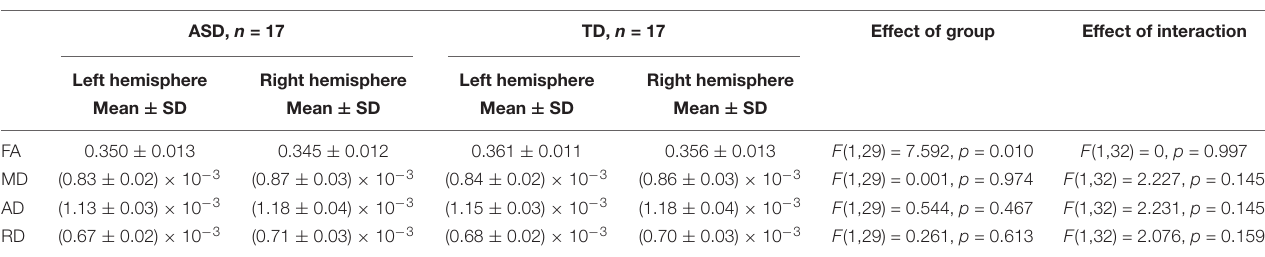
TABLE 2 | Tract-specific measurements of SC-pulvinar-amygdala in TCD data site. ASD, n = 17 TD, n = 17 Effect of group Effect of